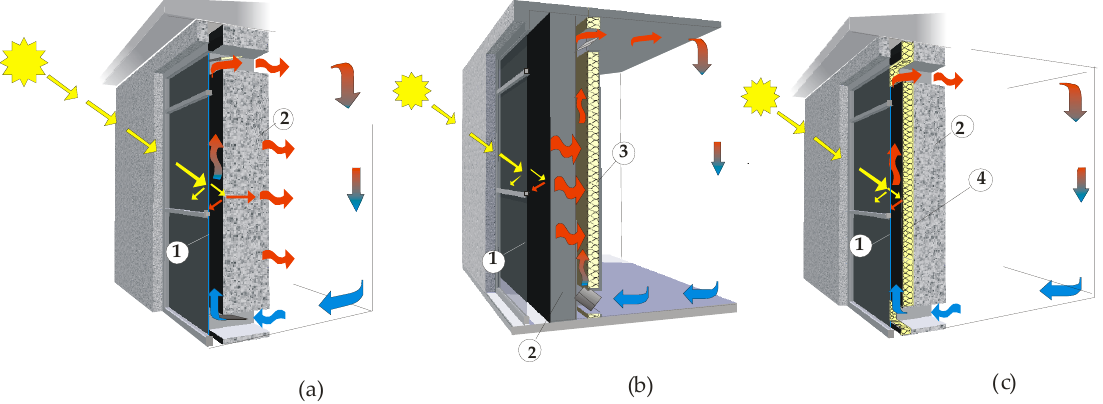
Figure 1. Thermal operation of passive walls: ( a ) classic Trombe wall, ( b ) composite Trombe wall with an insulating panel, ( c ) composite Trombe wall with a selective absorber. 1—glazing, 2—massive wall, 3—insulating polystyrene wall, 4—insulating layer directly behind the selective absorber.